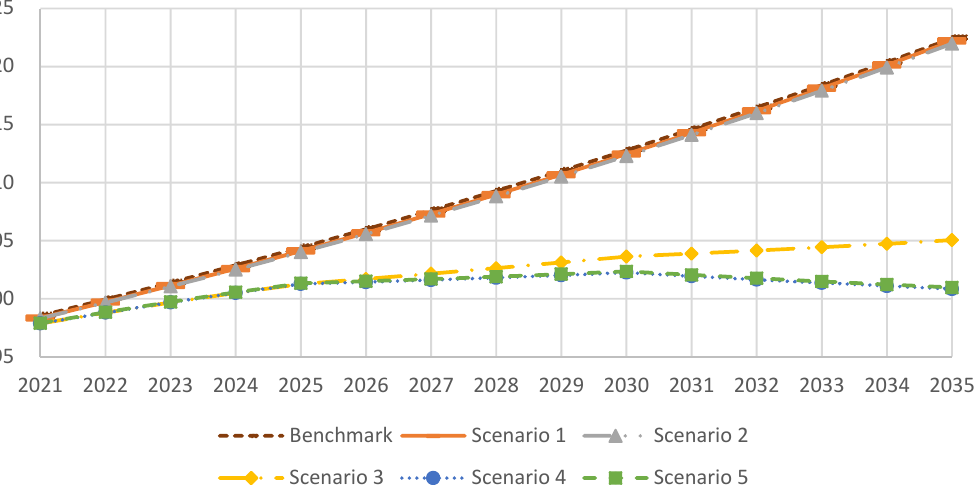
Figure 3. Carbon emissions simulation results of China’s energy consumption under different scenarios (100 million tons).